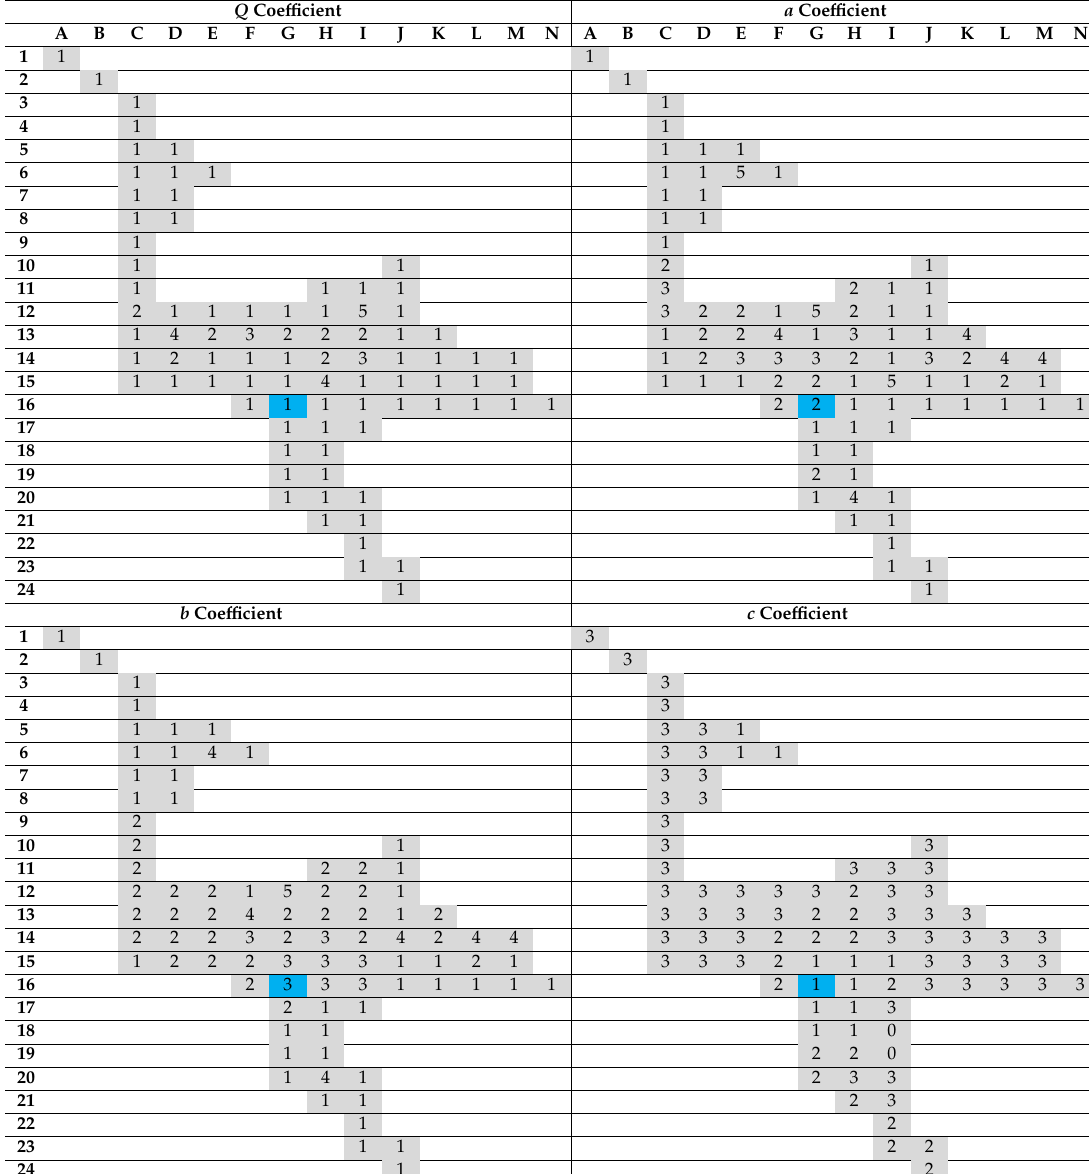
Table 5. Values of coe ffi cient ( Q ) describing the water demand in particular subareas, ( a ) denoting the required reliability of water supply to particular subareas, ( b ) corresponding to the failure to supply water of adequate quality to particular subareas and coe ffi cient ( c ) denoting the concentration of free chlorine in particular